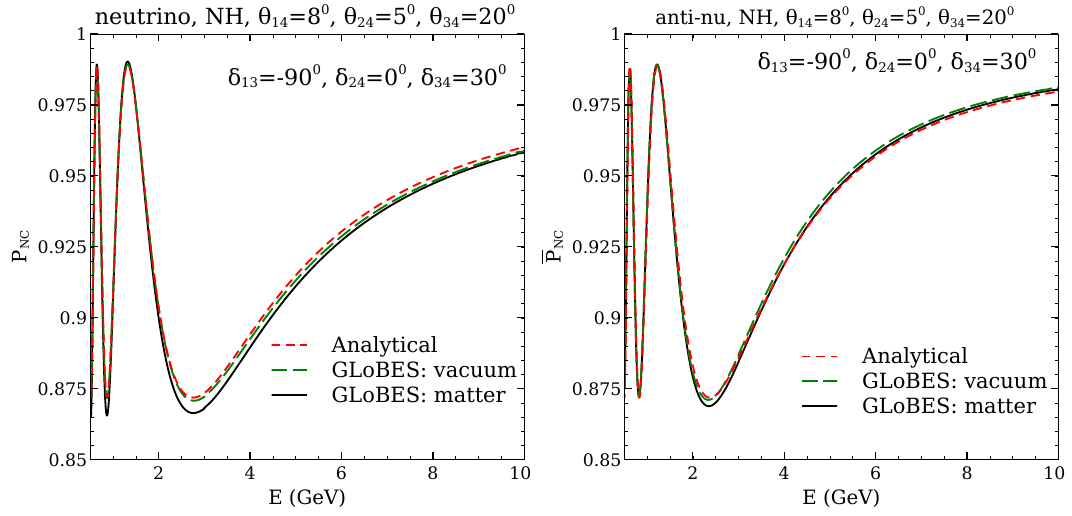
Figure 2 . Probability plots, comparing P NC = 1 (cid:0) P (cid:22)s using the approximate formula for P (cid:22)s given in the text, eq. (3.2) (red dashed curves) with the full GLoBES result in vacuum (green dashed curves) and matter (black solid curves). The left panel is for neutrinos and the right one for anti-neutrinos. Choices of phases and mixing angles have been made as shown. The curves correspond to L = 1300